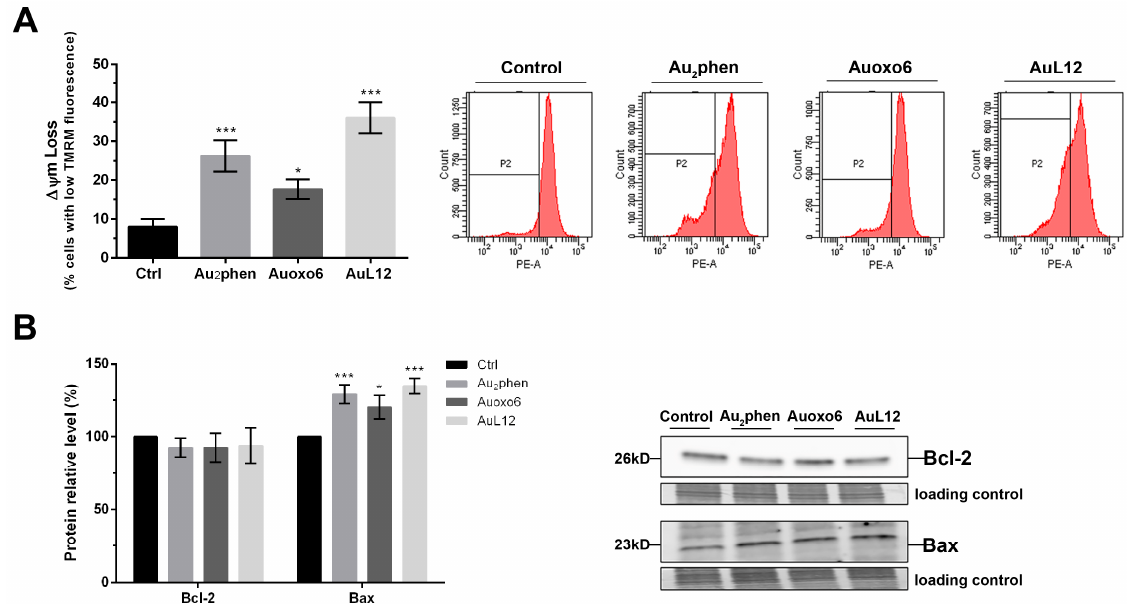
Figure 4. Involvement of mitochondrial membrane potential ( ∆ ψ m) dysfunction in gold(III)-induced apoptosis. A2780 cells were treated for 48 h with Au 2 phen, Auoxo6, and AuL12 72 h IC 50 -doses: ( A ) ∆ ψ m values obtained using fluorescent TMRM dye and flow cytometry analysis, whereby flow cytometric images are representative of three independent experiments and histograms report the percentages of treated cells with low TMRM fluorescence compared to controls; ( B ) Western blot analysis of Bcl-2 and Bax contents, whereby histograms report the normalized mean relative integrated density ( ± SD) values of Bcl-2 and Bax immunostained bands compared to controls. Representative immunoblots are also shown together with the matching Coomassie-stained PVDF membranes, which were used as loading control. Original Western blot images of Bcl-2 and Bax content are reported in Figure S3. All experiments were performed in triplicate. The statistical analysis was carried out using one-way ANOVA test followed by Tukey’s multiple comparisons test using GraphPad Prism software v 6.0 (* p < 0.05, *** p <